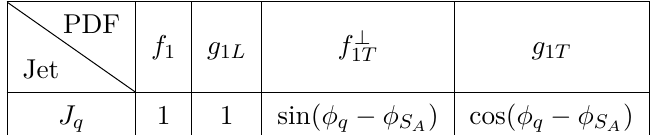
Table 2 . Summary of the characteristic azimuthal asymmetry with which different TMDPDFs arise for back-to-back electron-jet production. See eqs. (2.11) and (2.43) for details. sin( φ q − φ SA ) F